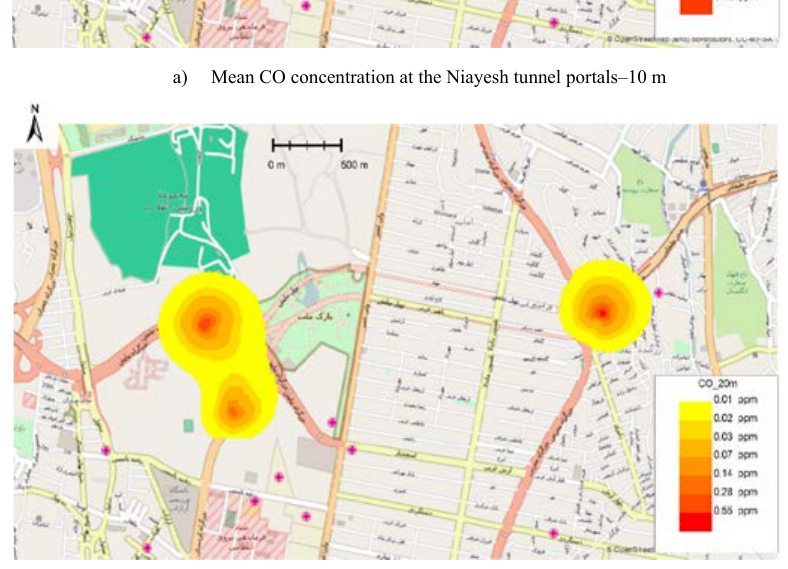
Fig. 6: Mean CO concentration at the Niayesh tunnel portals